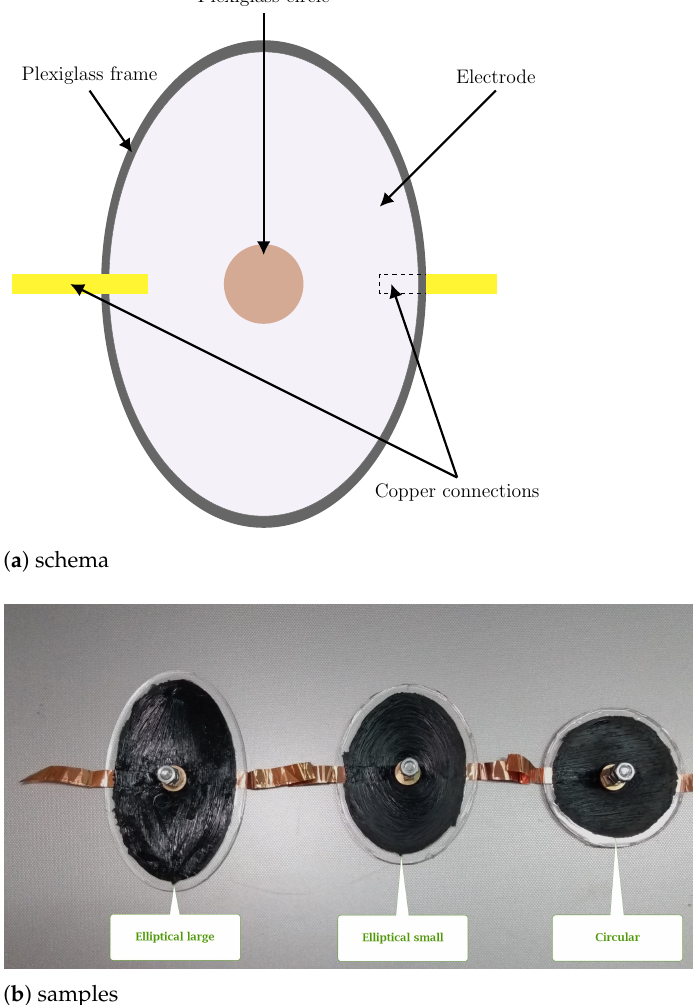
Figure 5. The schema of DEAP actuators and performed